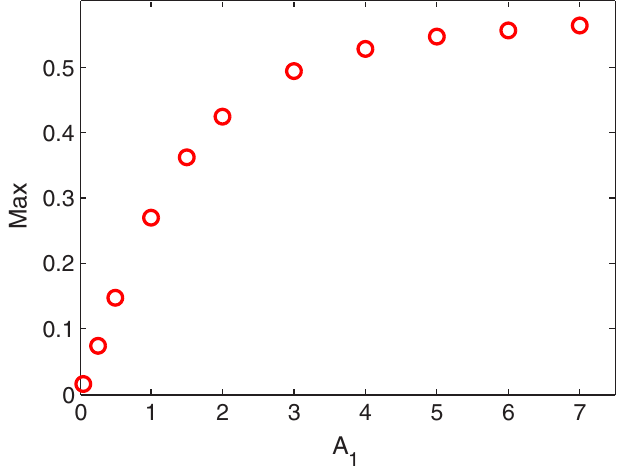
FIG. 2. (Color) Maximal value of J 1 ð A 1 (cid:5) Þ e (cid:2) (cid:5) 2 = 2 as a function of parameter A 1 .